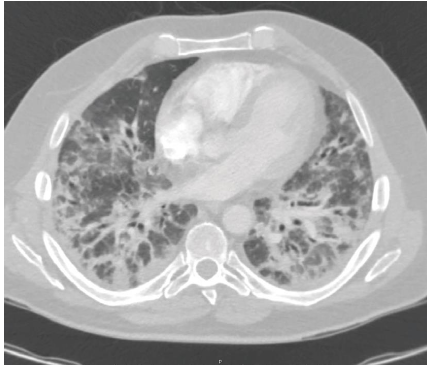
Figure 1: Chest CTshowing bilateral airspace opacities and ground glass opacities.